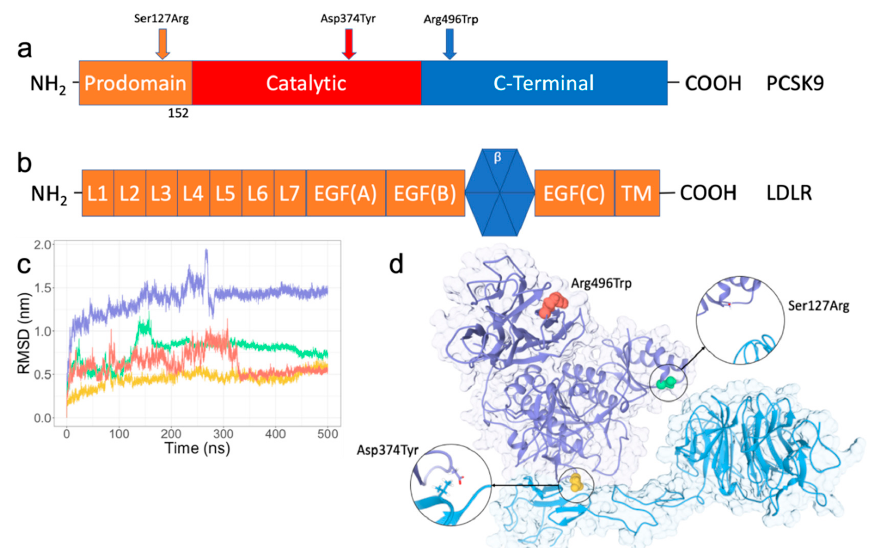
Figure 1. Depiction of the studied mutants. ( a ) Domain composition of proprotein convertase subtilisin / kexin type 9 (PCSK9). The prodomain (residues 31-152) is autocleaved and remains non-covalently bound to the catalytic domain. ( b ) Domain composition of low-density lipoprotein receptor (LDLR). The ligand binding domain is composed of seven (L1-L7) repeats, each roughly 40 amino acids in length. The epidermal growth factor precursor homology domain (EGFPH) is composed of epidermal growth factor precursor homology domain A (EGF(A)), the β -propeller, EGF(B), and EGF(C), and followed by a transmembrane region. ( c ) Root-mean-squared deviation (RMSD) plot for each trajectory over each 500-nanosecond production run. Wild-type is in purple, Ser127Arg is green, Asp374Tyr is yellow, and Arg496Trp is red. ( d ) Crystal structure of the PCSK9/LDLR complex (PDB ID: 3M0C). Clinically relevant mutations investigated in this study are depicted as spheres. Insets indicate the protein–protein interactions incident at positions 127 and 374.